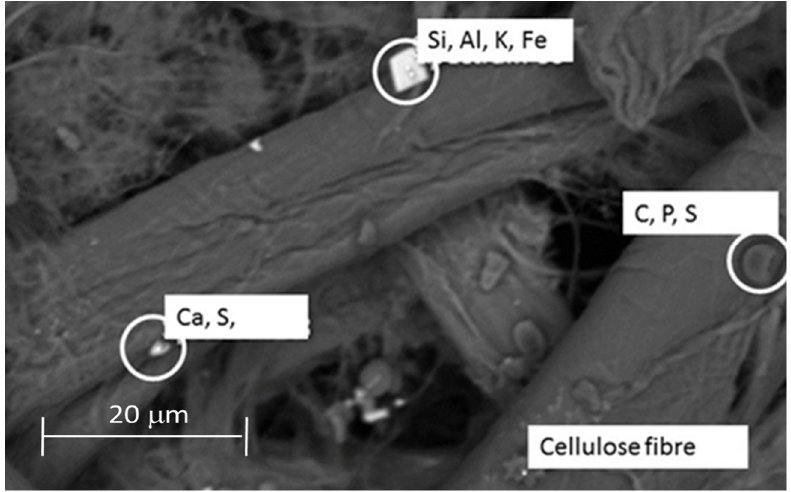
Figure 3. Backscattered electrons’image of the sample shows three types of particulates collected on the cellulose fibrous filter.